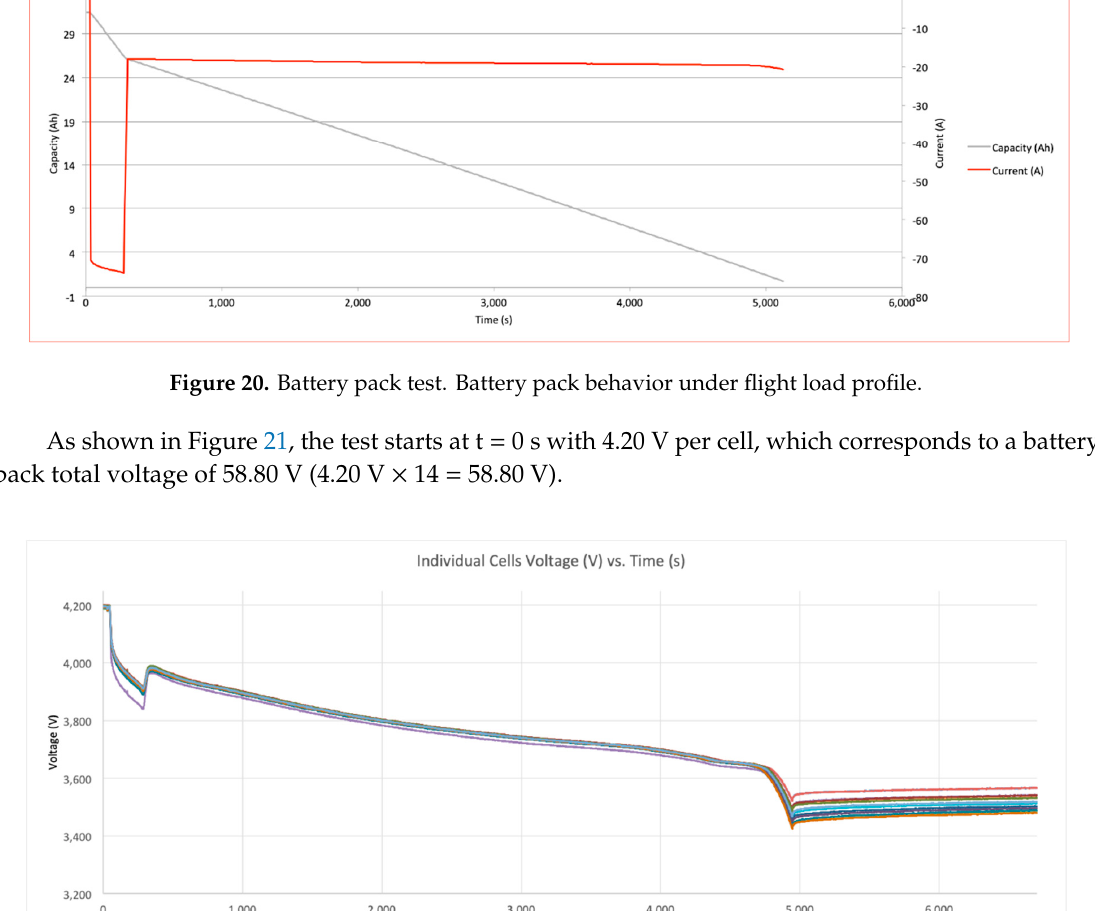
Figure 19. Battery pack test. Battery pack behavior under flight load profile.